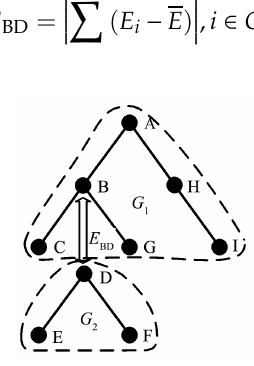
Figure 6. Minimum spanning tree topological connection and energy transfer.